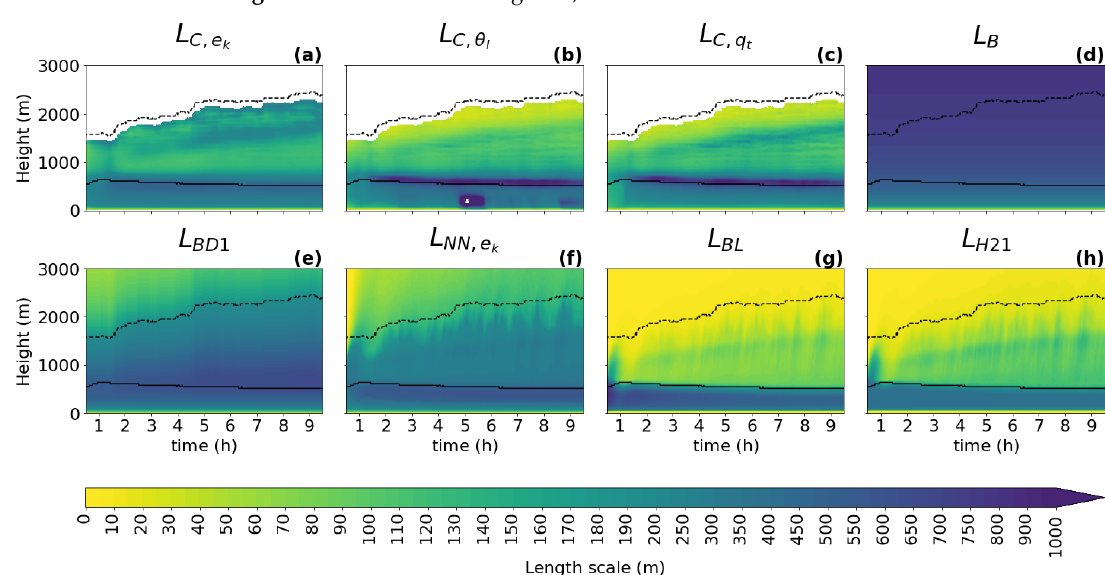
Figure 5. Same content as Figure 3, but for the RICO